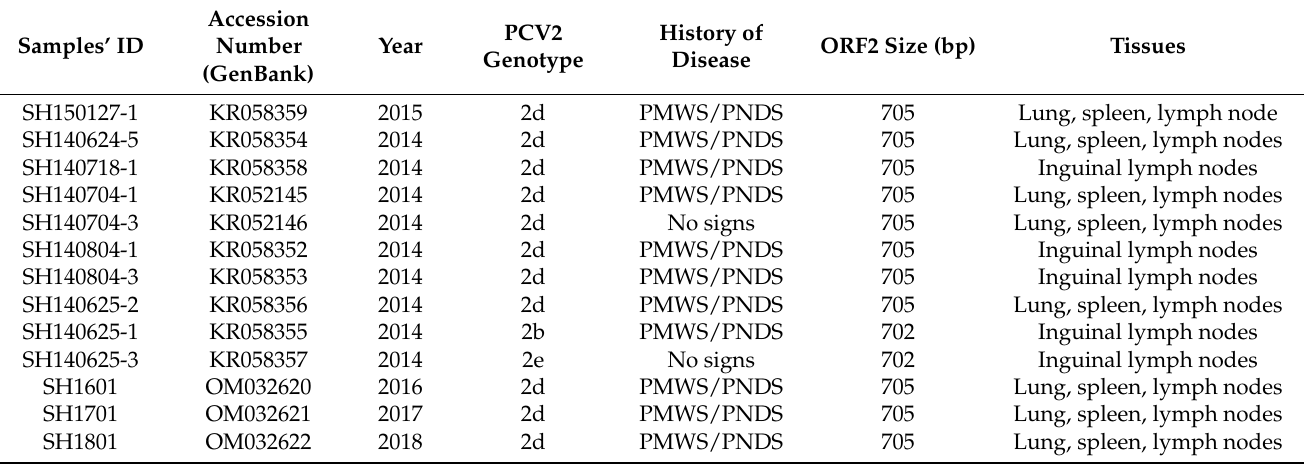
Table 3. Summary of PCV2 (Cap gene) isolates from Shanghai pig farms during this study and their GenBank accession